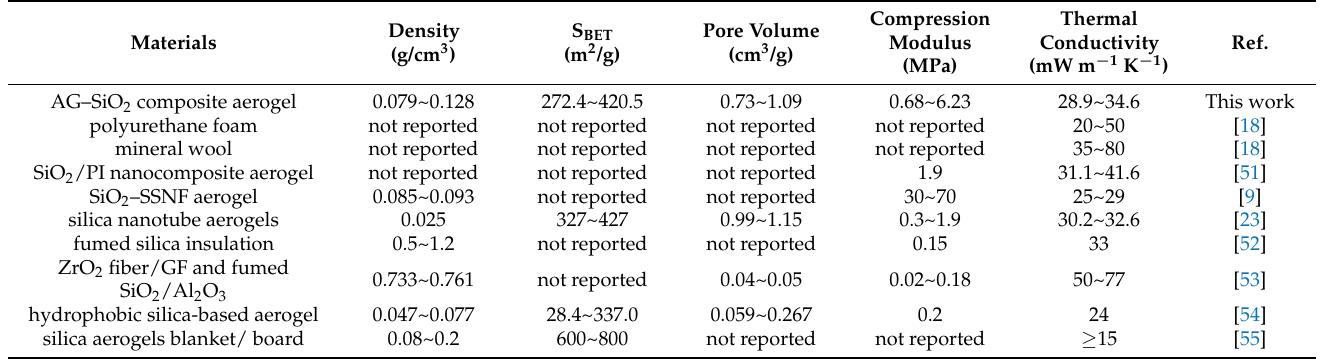
Table 2. Comparison of the properties of the CAs and other silica-based aerogel